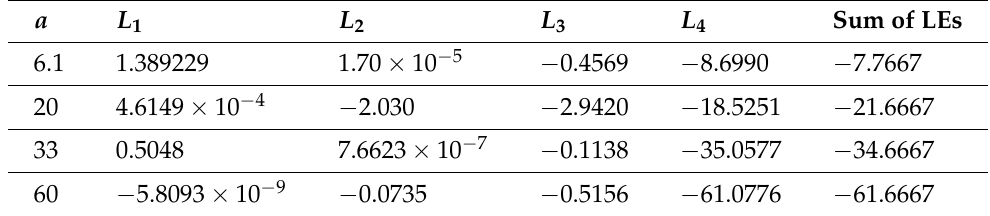
Table 1. The Lyapunov exponents for different a